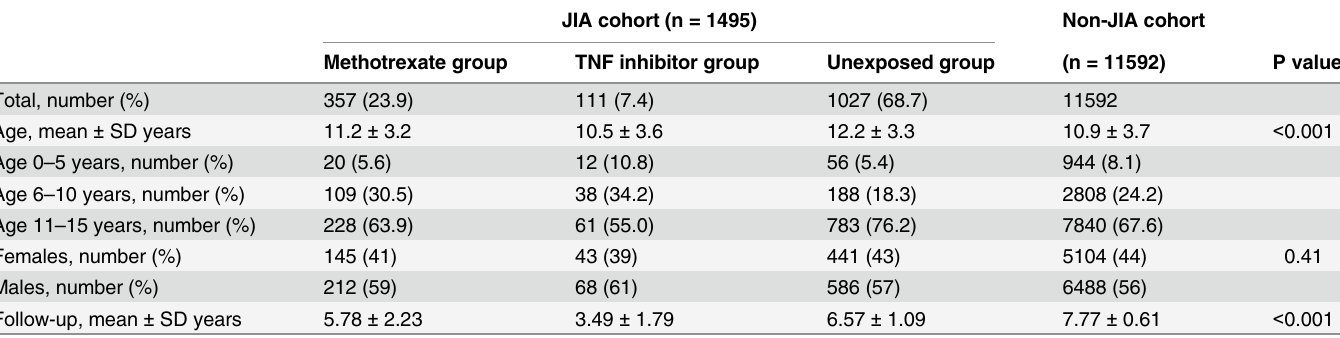
Table 1. Baseline characteristics of the study cohort.